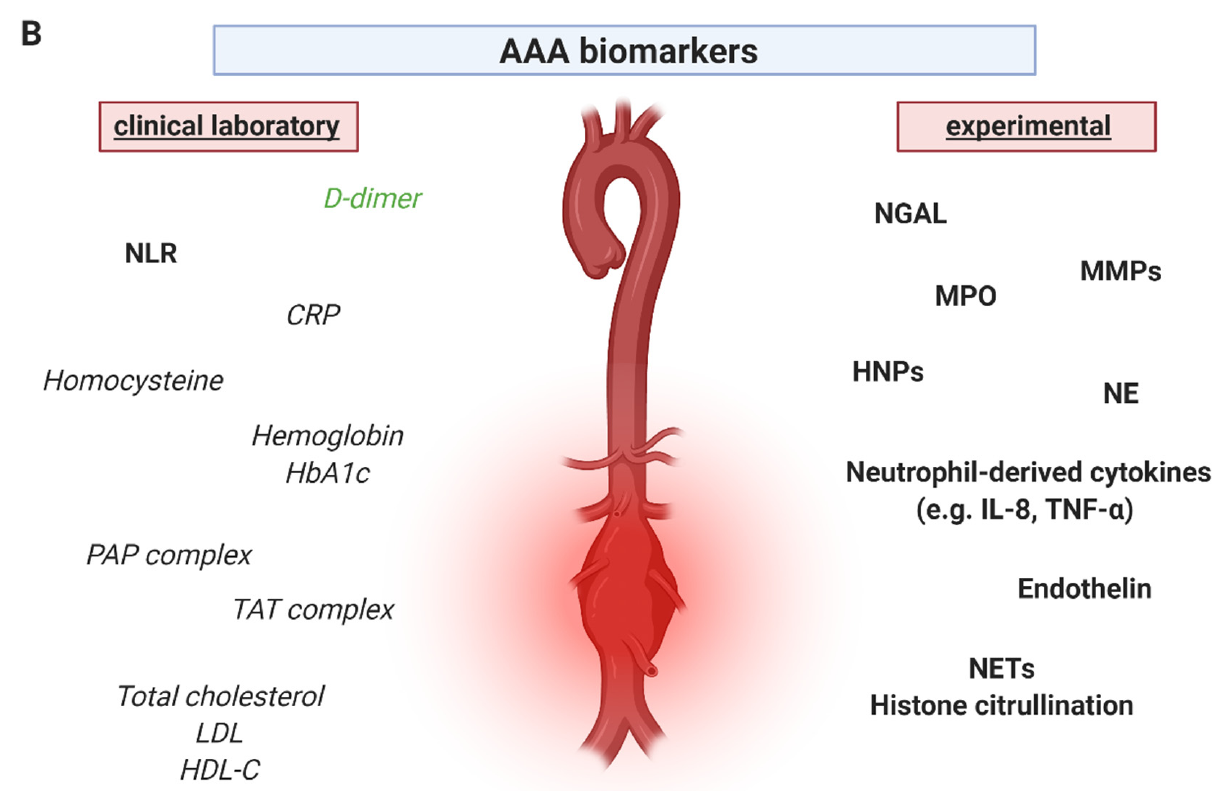
Figure 1. Overview of classical neutrophil functions as well as investigated AAA biomarkers. ( A ) Neutrophils are polymorphonuclear leukocytes that serve as the initial line of defense against invading pathogens and moreover play a key role in a variety of inflammatory conditions and cardiovascular diseases such as AAA. These granulocytes exert several classical functions, which can act as a double-edged sword of neutrophil antimicrobial function, but excessive activation can damage host tissue. Upon cell activation, several soluble neutrophil granule proteins are released. Phagocytosis and release of neutrophil extracellular traps are evolutionary conserved mechanisms of the unspecific immune defense, however, besides the desired antimicrobial functions, they may also contribute to the acute or chronic pathogenesis of vascular diseases. The production of cytokines by activated neutrophils is striking in its diversity. Neutrophils synthesize and release a variety of pro- and anti-inflammatory cytokines as well as growth factors. Additionally, neutrophils interact with surrounding immune cells and humoral factors leading to modification of cell recruitment and signal cascades via cytokine and microvesicle release. Triggered neutrophils activate their NADPH oxidase to generate substantial amounts of superoxide and other reactive oxygen species, which play a vital role in the progression of cardiovascular diseases. ( B ) In performing their functions, neutrophils provide a multitude of potential biomarkers, which can be used to improve the diagnosis and prognosis of AAA as well as postoperative outcome. To facilitate data presentation, this overview shows clinically available and experimental biomarkers, which have been investigated, but are currently not used in clinical practice. This selection presents neutrophil-derived biomarkers indicated in bold, clinical biomarkers in italics and specifically the most commonly applied clinical biomarker D-dimer in green. MPO: myeloperoxidase; NE: neutrophil elastase; NGAL: neutrophil gelatinase-associated lipocalin; MMP: matrix metalloproteinase; IL: interleukin; TNF- α : tumor necrosis factor- α ; ROS: reactive oxygen species; AAA: abdominal aortic aneurysm; NLR: neutrophil-to-lymphocyte ratio;